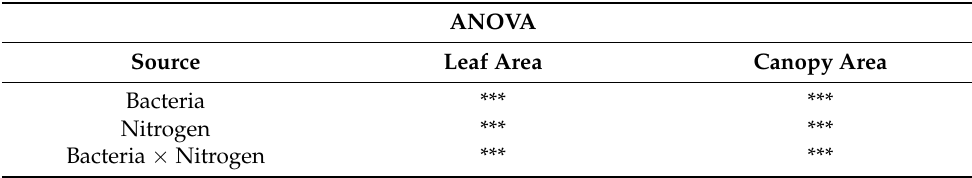
Table 2. Leaf area and canopy area in hydroponically grown lettuce influenced by Azotobacter under different nitrogen levels. Significant differences: *** p <